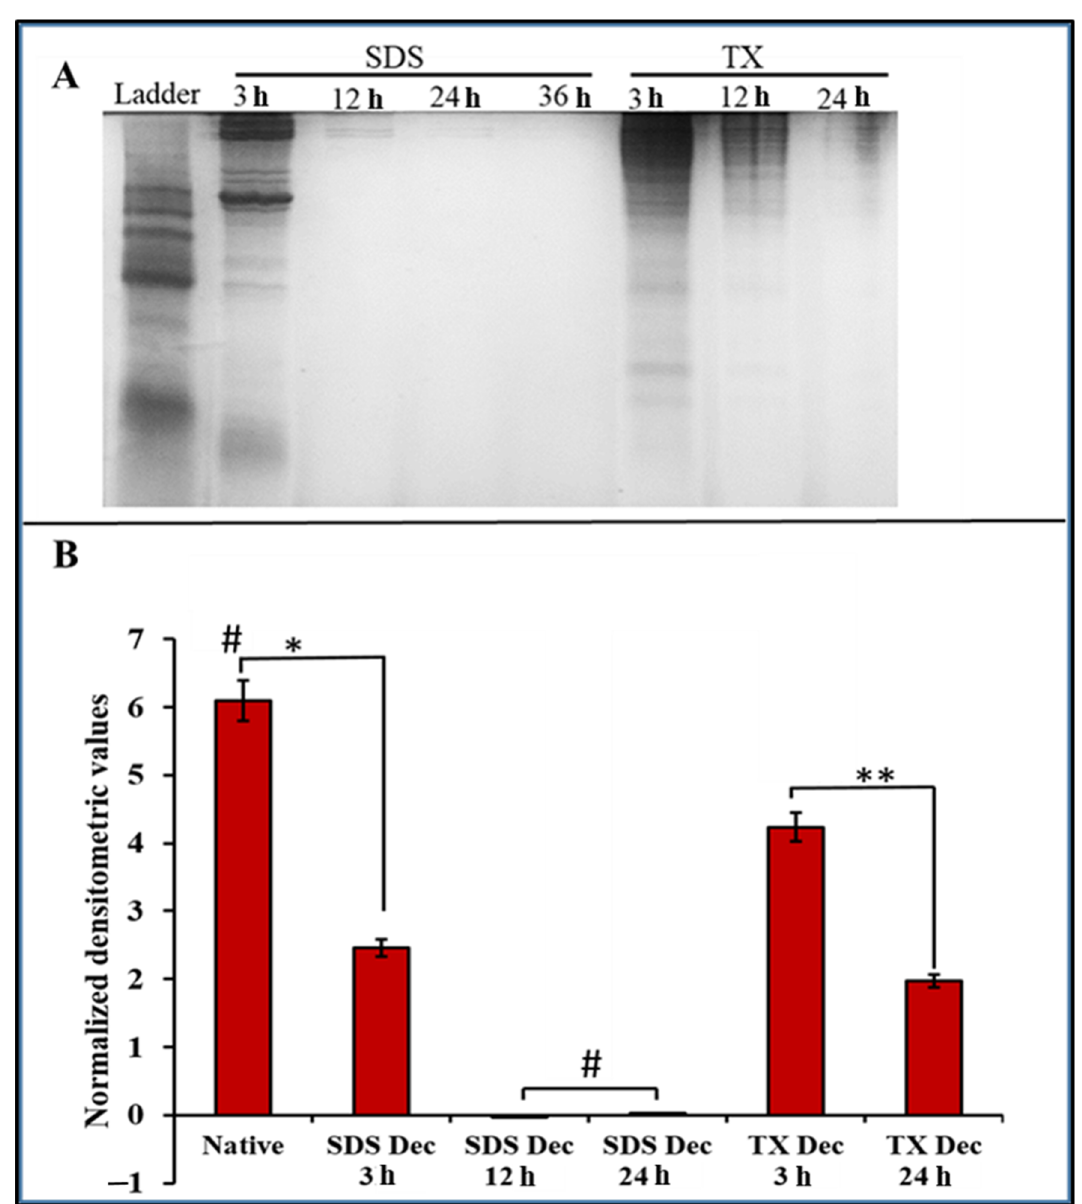
Figure 5. Charts showing the total cellular protein and nucleic acid content of decellularized scaf- folds at different time points of decellularization. ( A ) SDS-PAGE of cellular proteins after decellularization in 1% SDS decellularization treatment or 1% Triton-X decellularization treatment. ( B ) Quantitative analysis of total cellular protein of decellularized cartilage tissue after 1% SDS decellularization treatment or 1% Triton-X decellularization treatment. * p- value = 0.0003, # p- value < 0.00007, ** p- value = 0.02742; n = 3.